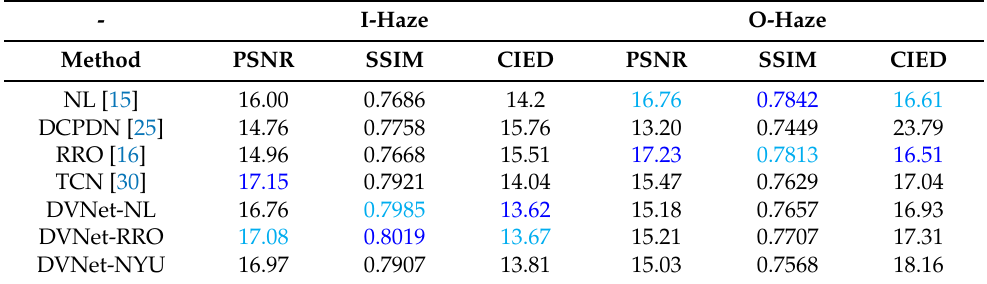
Table 4. Comparison with state-of-the-art dehazing method using various benchmark dataset, where blue and cyan colored numbers are the best and secondly best scores.